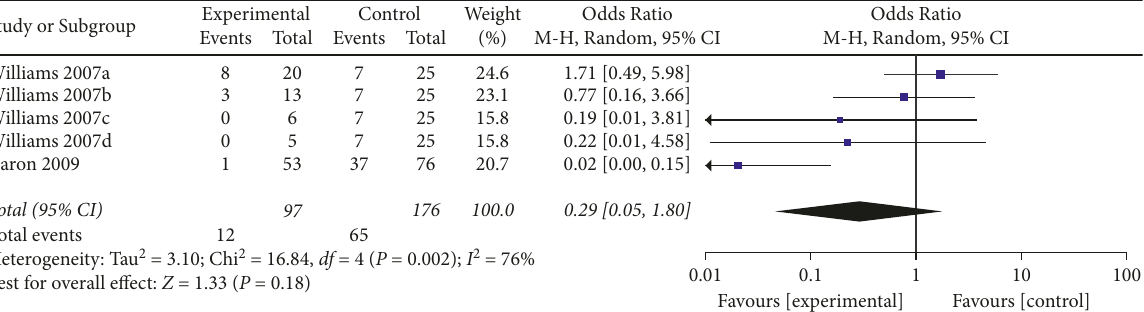
Figure 8: Forest plot of ADRs associated with antivenom use following snakebite between the prehydrocortisone with or without other drugs groups and the placebo or no premedication groups in five comparisons from two cohort